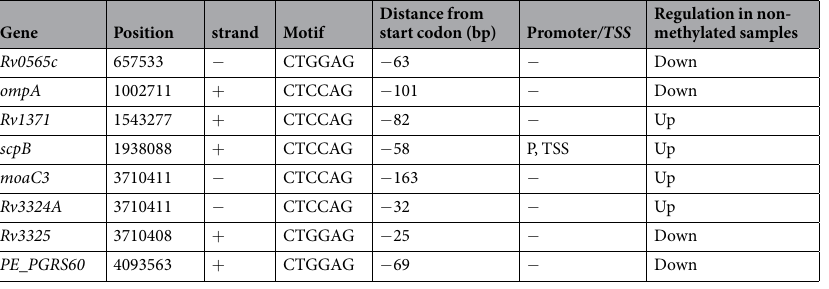
Table 3. cis -eQTLs located in upstream intergenic regions linked with methylation in Lineage 4 strains. Table showing genes differentially expressed potentially due to the lack of methylation in the upstream region. The name of the gene, the position of the eQTL (methylation site), strand, motif, distance of the methylated base from start codon of the transcript (negative shown as upstream), prediction of promoter or TSS (P = promoter region, TSS = Transcriptional Start Site), and type of regulation of the gene in non-methylated samples is